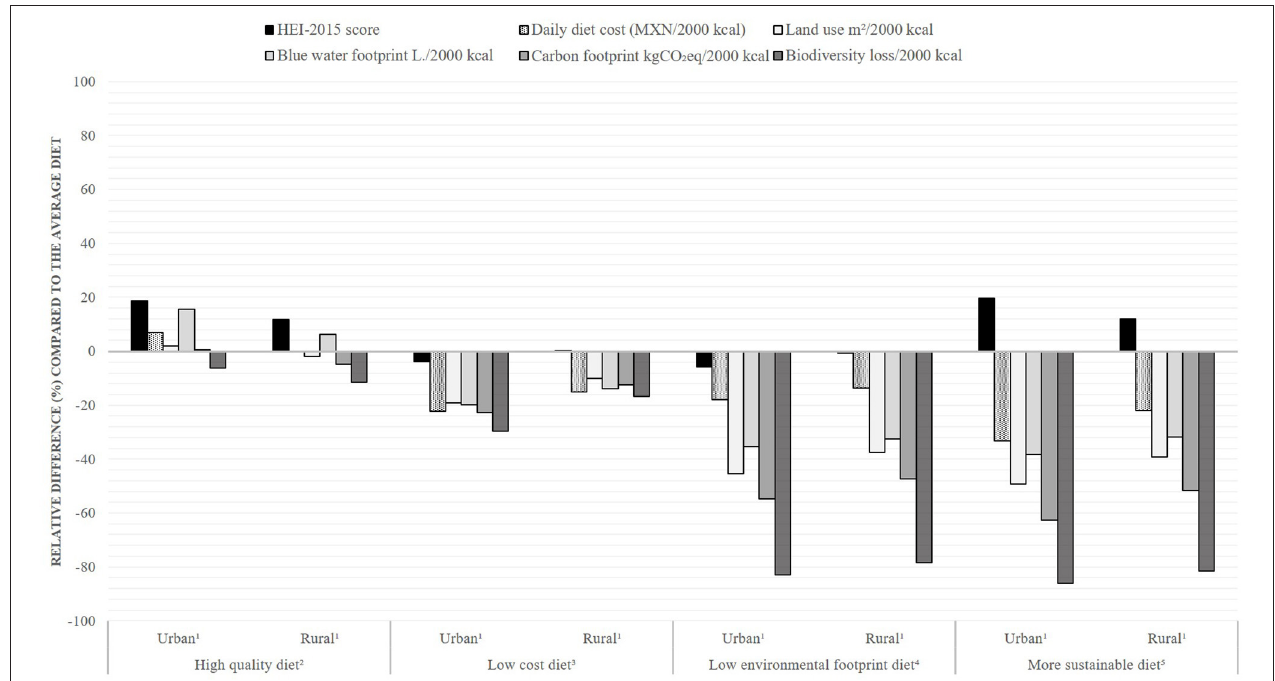
FIGURE 1 | Difference in dietary indicators of high-quality, low-cost, low-environmental footprint, and more sustainable diets relative to the average diet, by area of residence in Mexico. Values presented are the percentage difference in each dietary indicator (HEI-2015, cost and environmental footprint) relative to the average diet. 1 Urban: more than 2,500 inhab; Rural: less than 2,500 inhab. 2 Diets with HEI-2015 score above the overall median (54.2). 3 Diets with daily diet cost below the median (50.9 MXN ≈ 2.6 USD). 4 Diets with all environmental indicators below the median: land use (5.5 m 2 ), blue water footprint (361L), carbon footprint (3.4 kgCO 2 eq), and biodiversity loss (423 potential species loss × 10 − 10 ). 5 Diets combining the criteria for high-quality, low-cost, and low-environmental-footprint diets. HEI-2015, Healthy Eating